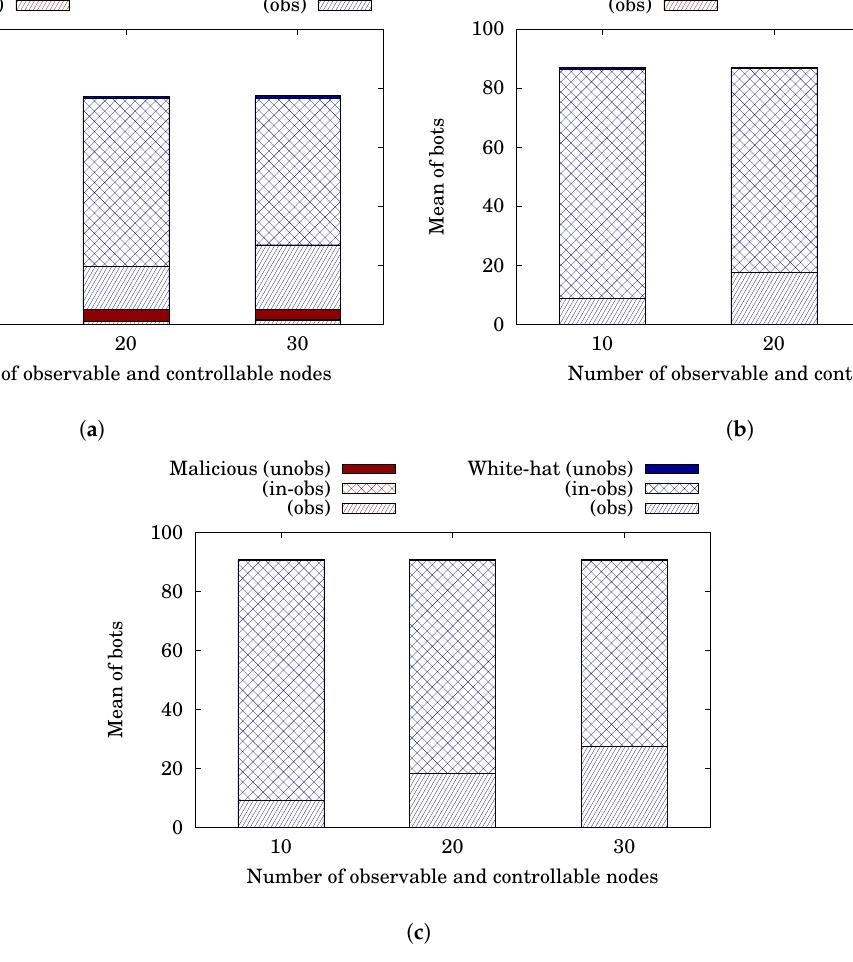
Figure 12. Simulation results in the general case. ( a ) Lifespan (cid:96) = 3 steps; ( b ) Lifespan (cid:96) = 4 steps; ( c ) Lifespan (cid:96) = 5